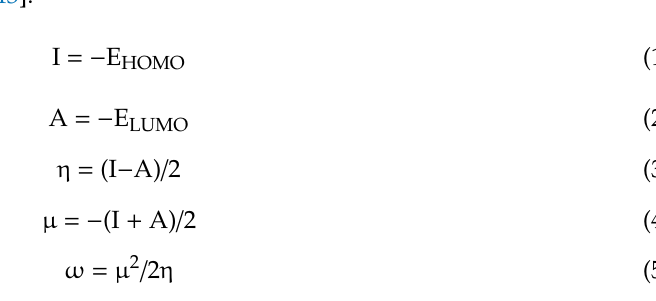
Table 3. The stabilization energies E (2) (kcal/mol) and the charge transfer interactions in the target compound a .